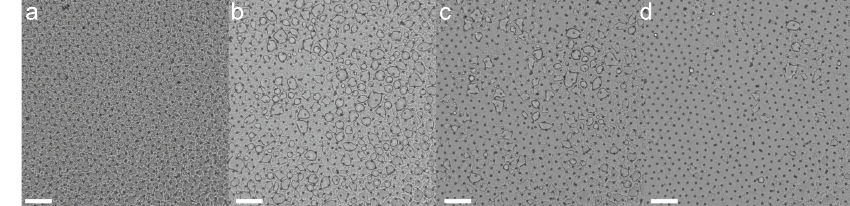
Figure 6. Sequence of bright field microscopy images of the nylon membrane forming at the water–decane interface taken 30 ( a ); 120 ( b ); 180 ( c ) and 240 ( d ) minutes after sebacoyldichloride injection. Scale bars are 50 µ